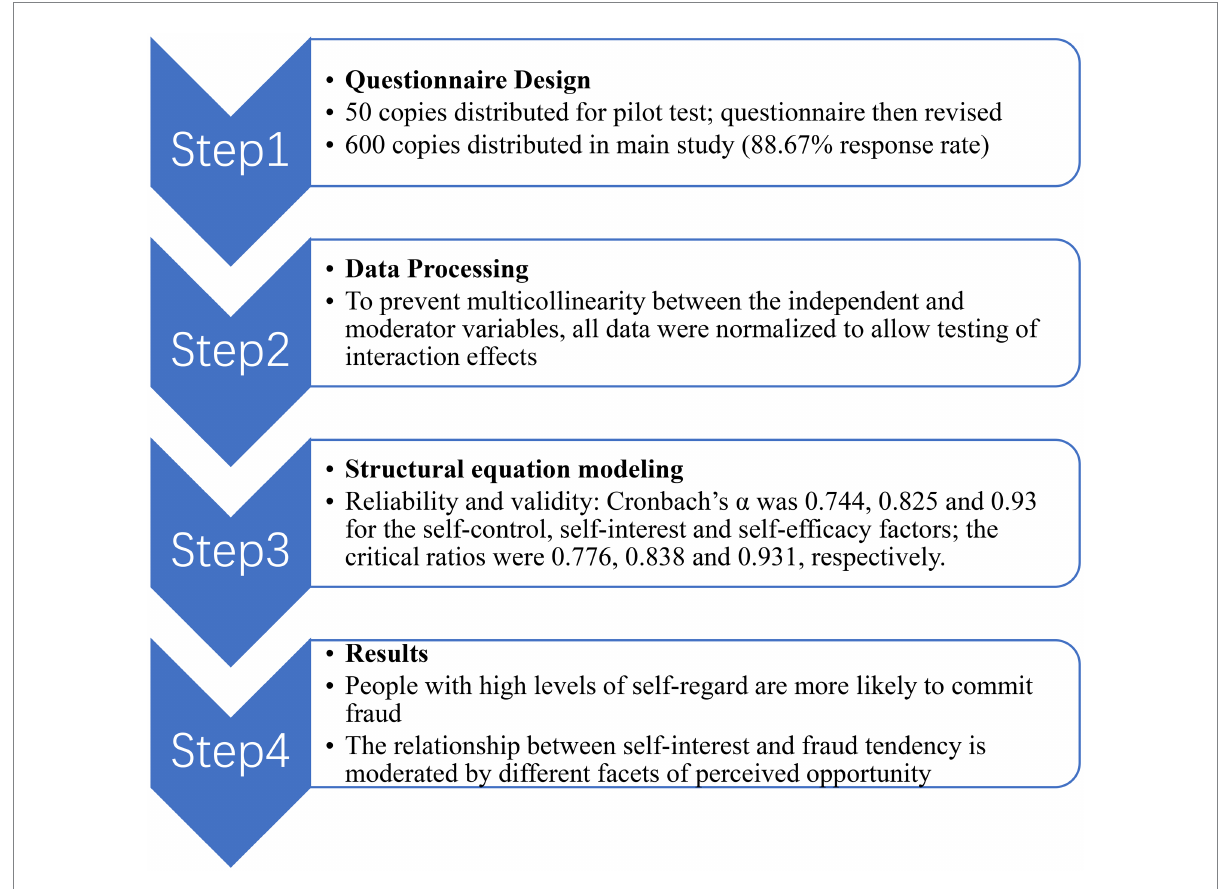
FIGURE 2 Methodological approach.